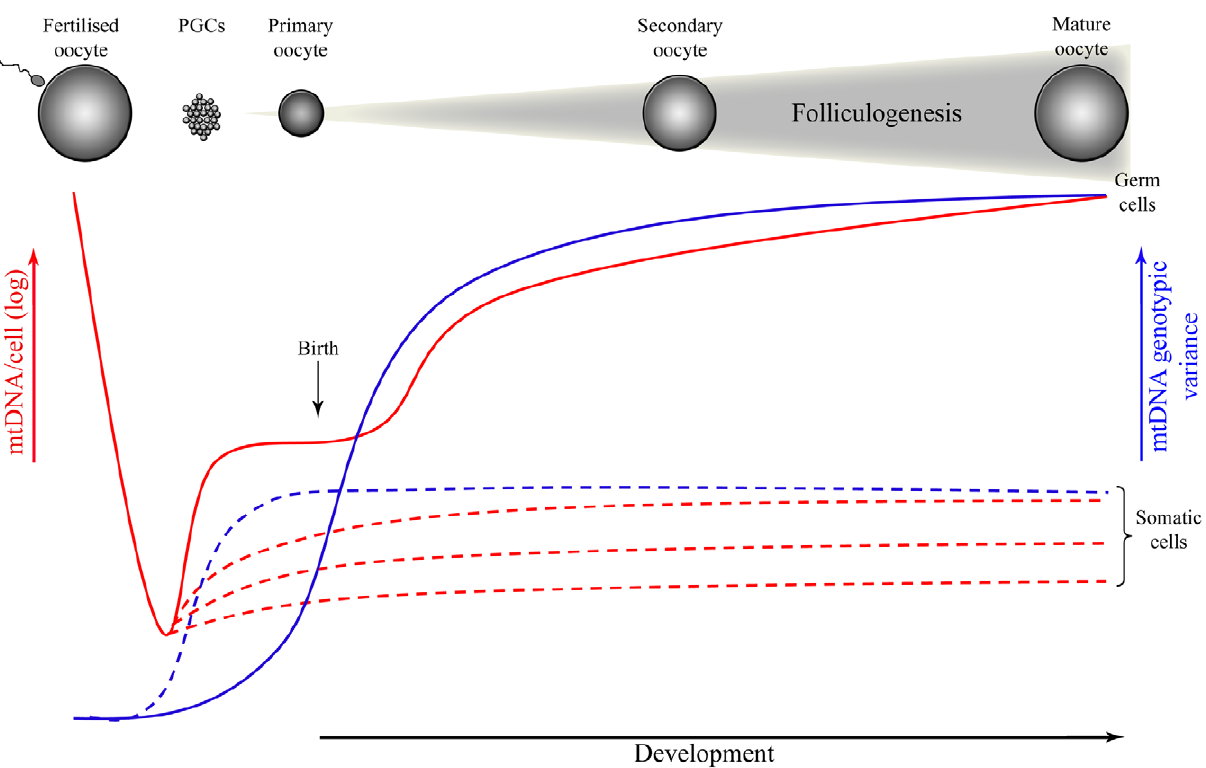
Figure 1. Mitochondrial DNA (mtDNA) copy number and genotypic variance throughout development in germ and somatic cells of mammals. Although mtDNA genotypic variance in somatic cells increases early during development due to cellular differentiation, according to recent findings this will only occur later in germ-line development, during folliculogenesis that takes place after birth. If this is correct, then the mitochondrial genotype of the next generation would be defined only during adulthood, during the folliculogenesis that occurs every cycle of 28 days in